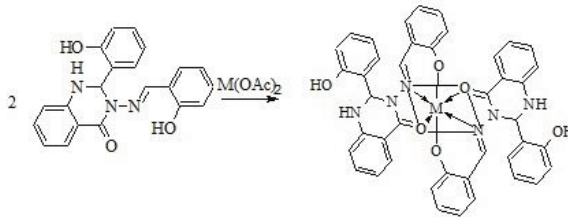
Scheme 3: Formation of Octahedral complexes of HHAQ - with M(II)